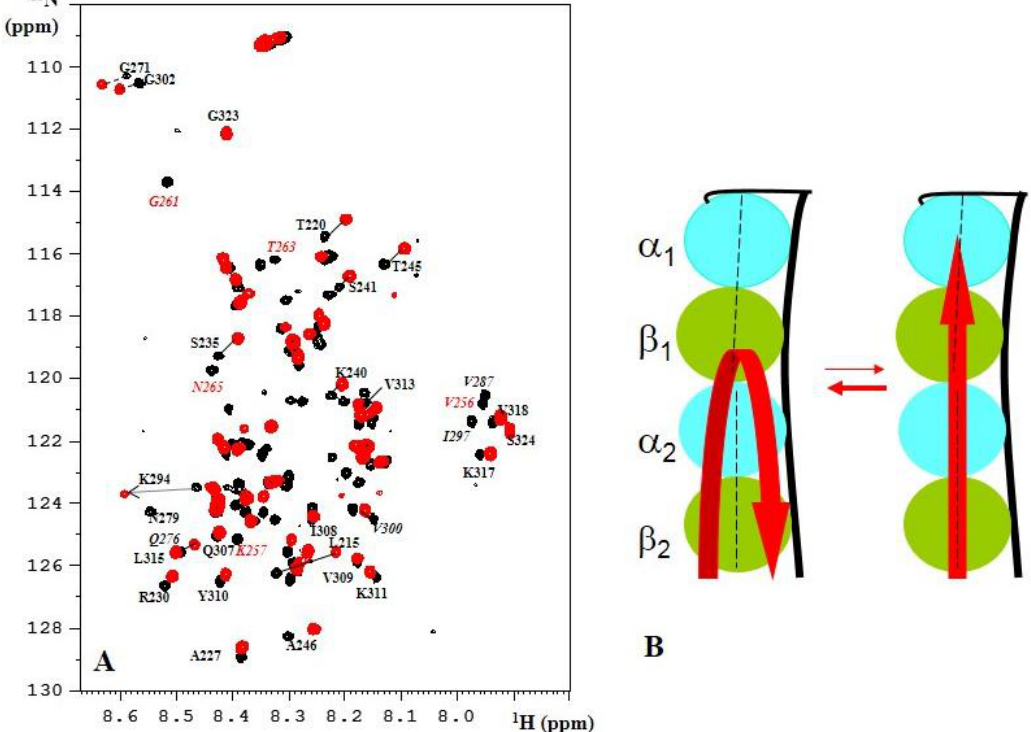
Figure 2. ( A ) The 1 H, 15 N TROSY spectrum of TauF4 in its complex with T 2 R. Residues in the R1 repeat whose resonances are absent in the TauF4-T 2 R spectrum are labeled in red; ( B ) Model of the swing movement of TauF4 on the curved T 2 R surface [76].